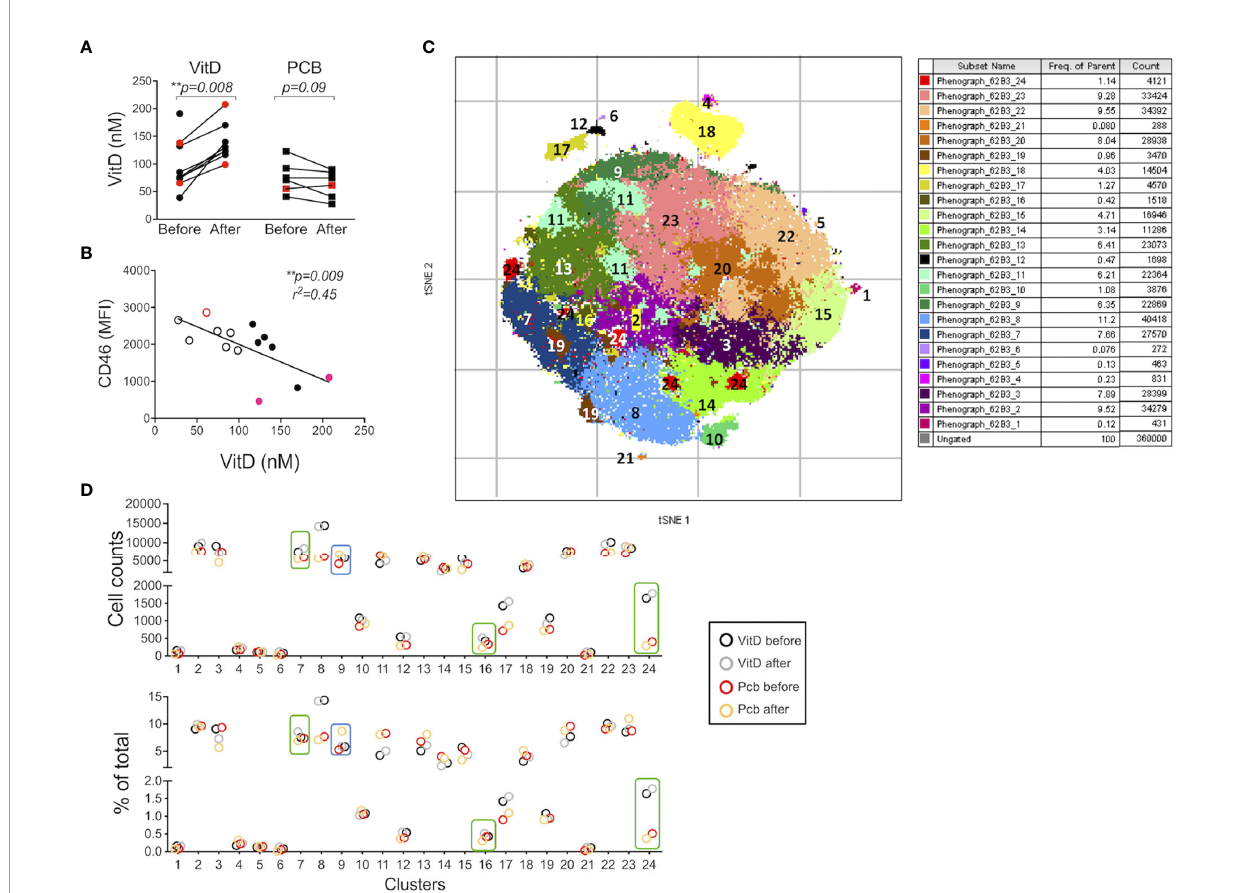
FIGURE 6 | Vitamin D supplementation modulates the phenotype of T cells in patients with multiple sclerosis (MS) in vivo . (A) 25(OH)D levels in serum before and after a 16-week treatment with vitamin D or placebo (PCB) in a cohort of patients with MS (11 IFN b -treated, 3 untreated, red dots). (B) Correlation between the expression of CD46 on circulating CD3+CD4+ T cells and vitamin D concentration. Placebo: open circles, vitamin D: closed symbols, untreated patients depicted as red dots. (C) t-SNE was run on the concatenate fi le of 360,000 cells (perplexity = 100, iteration = 1000, Eta= 44,099). Phenograph was also run to identify clusters (K=50) in the CD3+CD4+ T cells from fi ve patients supplemented with vitamin D and four placebo (all IFN b treated). (D) Cell counts and percentage of the 24 clusters identi fi ed by PhenoGraph (in C ) in the vitamin D and placebo groups before and after treatment. Boxes identi fi ed the clusters for which a differential modulation was observed with vitamin D and